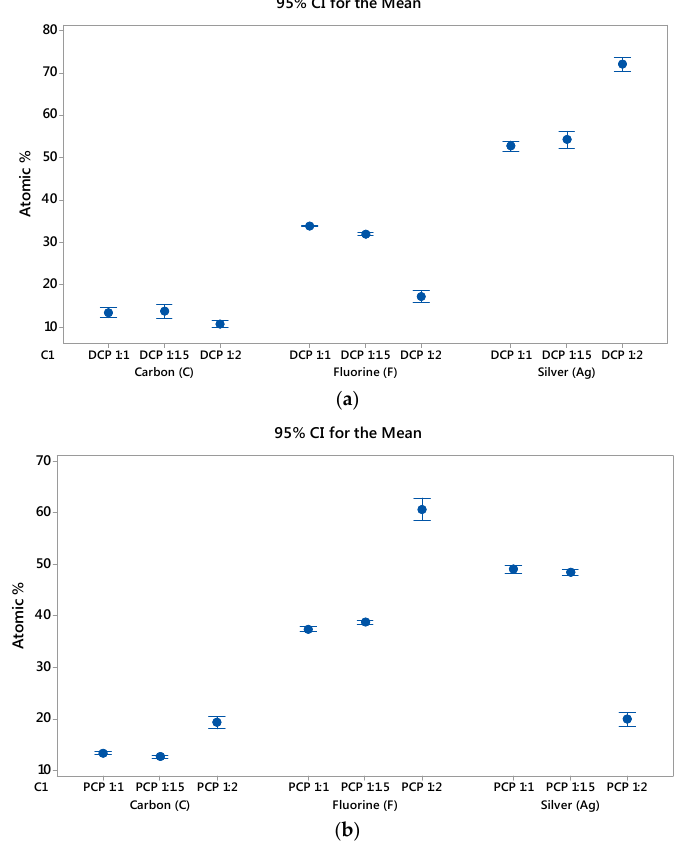
Figure 5. Normalised EDS element at % by PTFE:FC ‐ 4 ratio for ( a ) DCP and ( b ) PCP. Individual standard deviations are used to calculate the intervals.